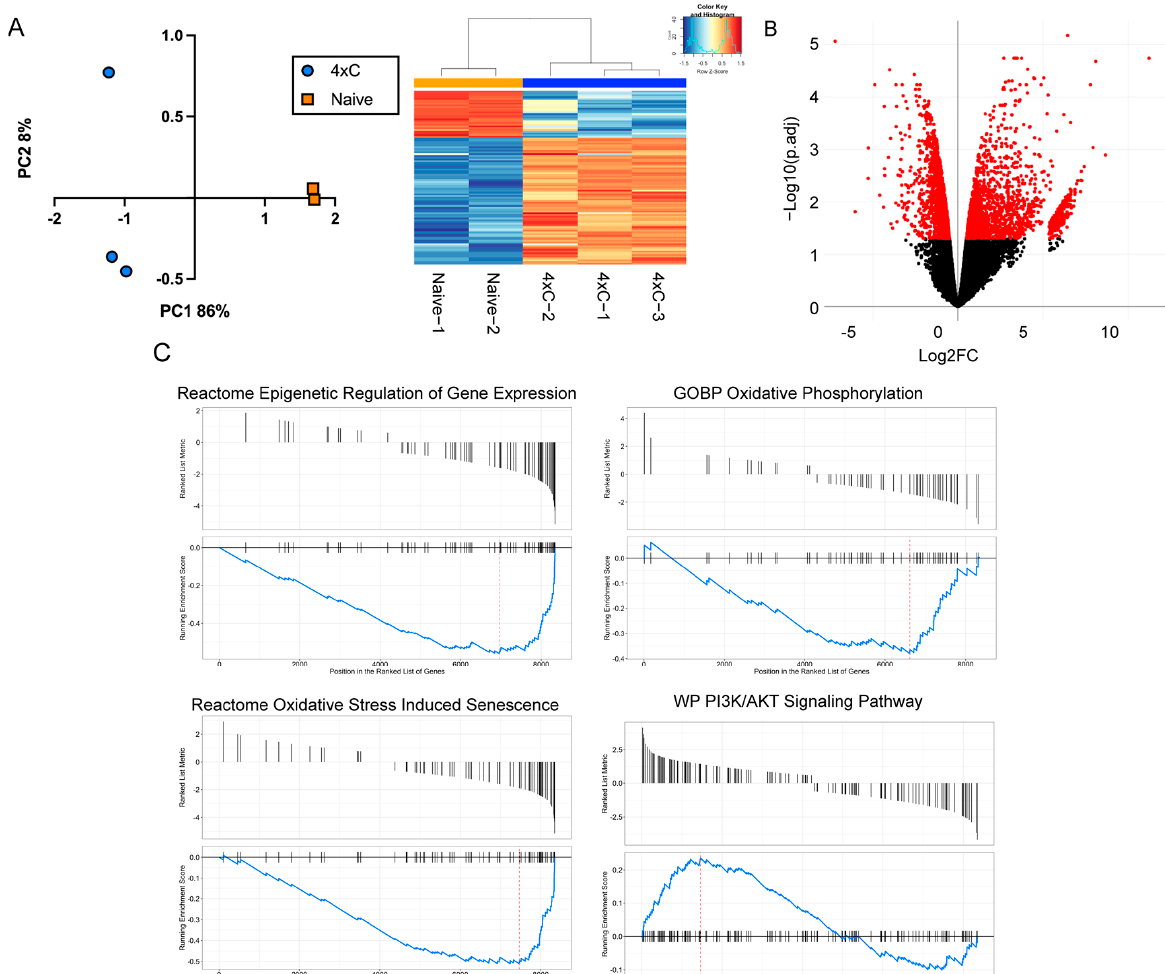
Figure 2. Transcriptomic changes associated with recurrent carboplatin exposure. ( A ) PCA plot and heatmap comparing RB028 4 × C versus RB028 Naïve . ( B ) Volcano plot of RB028 4 × C versus RB028 Naïve (red dots represent genes with FDR < 0.05). ( C ) GSEA analysis identifies pathways involved in early resistance reprogramming events (adjusted p < 0.05).